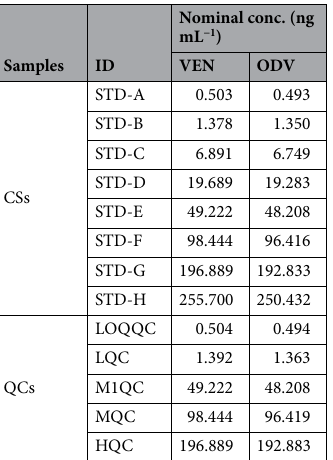
Table 1. Nominal concentration of calibration standard and quality control samples.